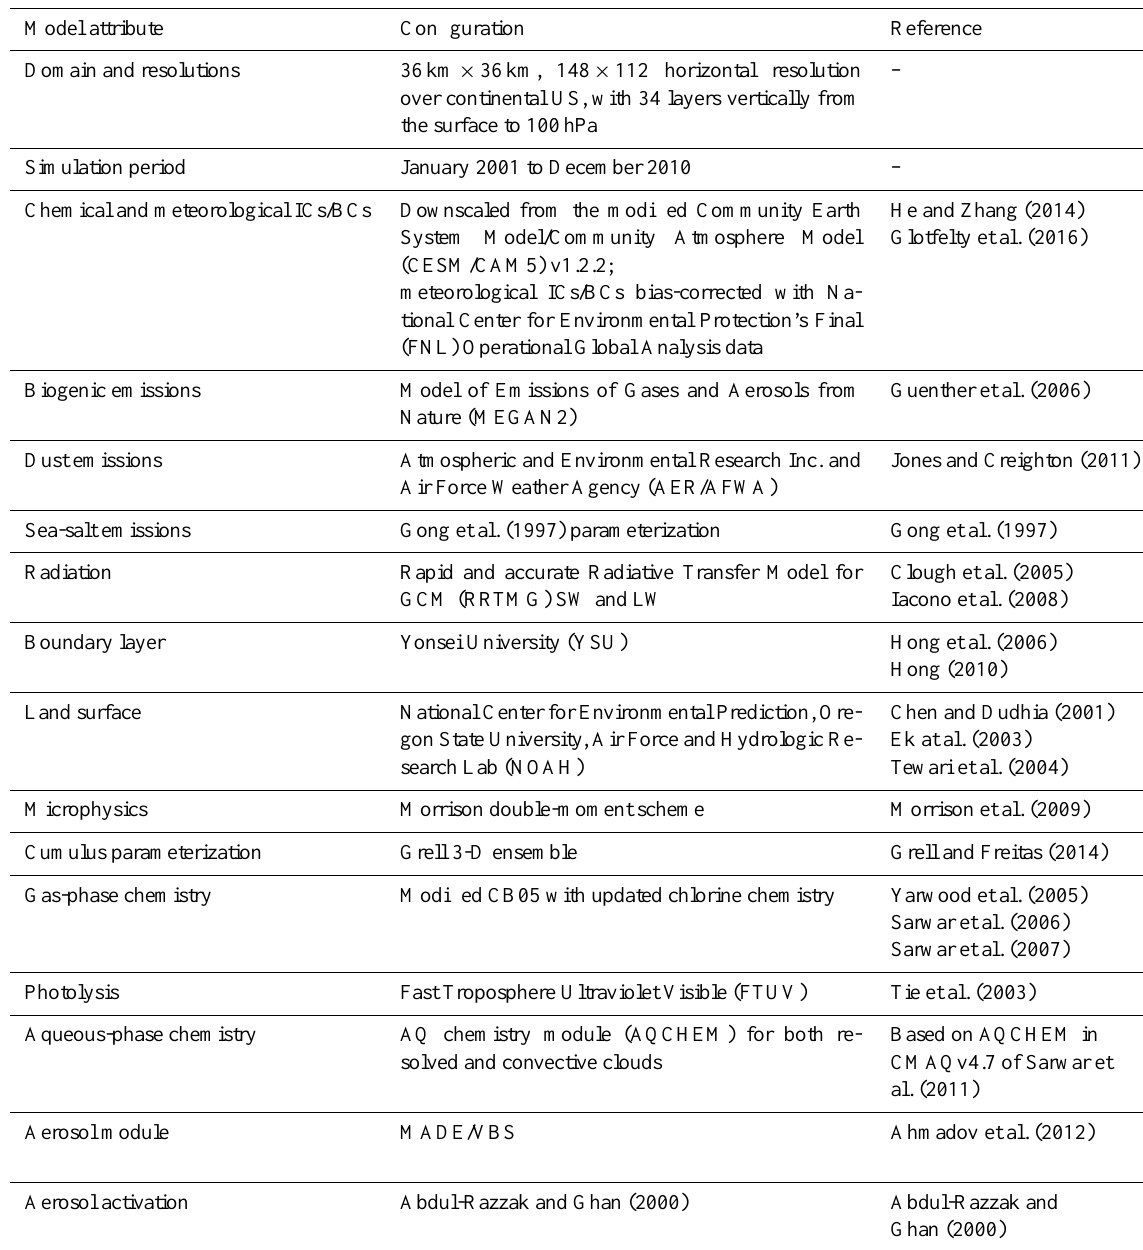
Table 1. Model configurations and